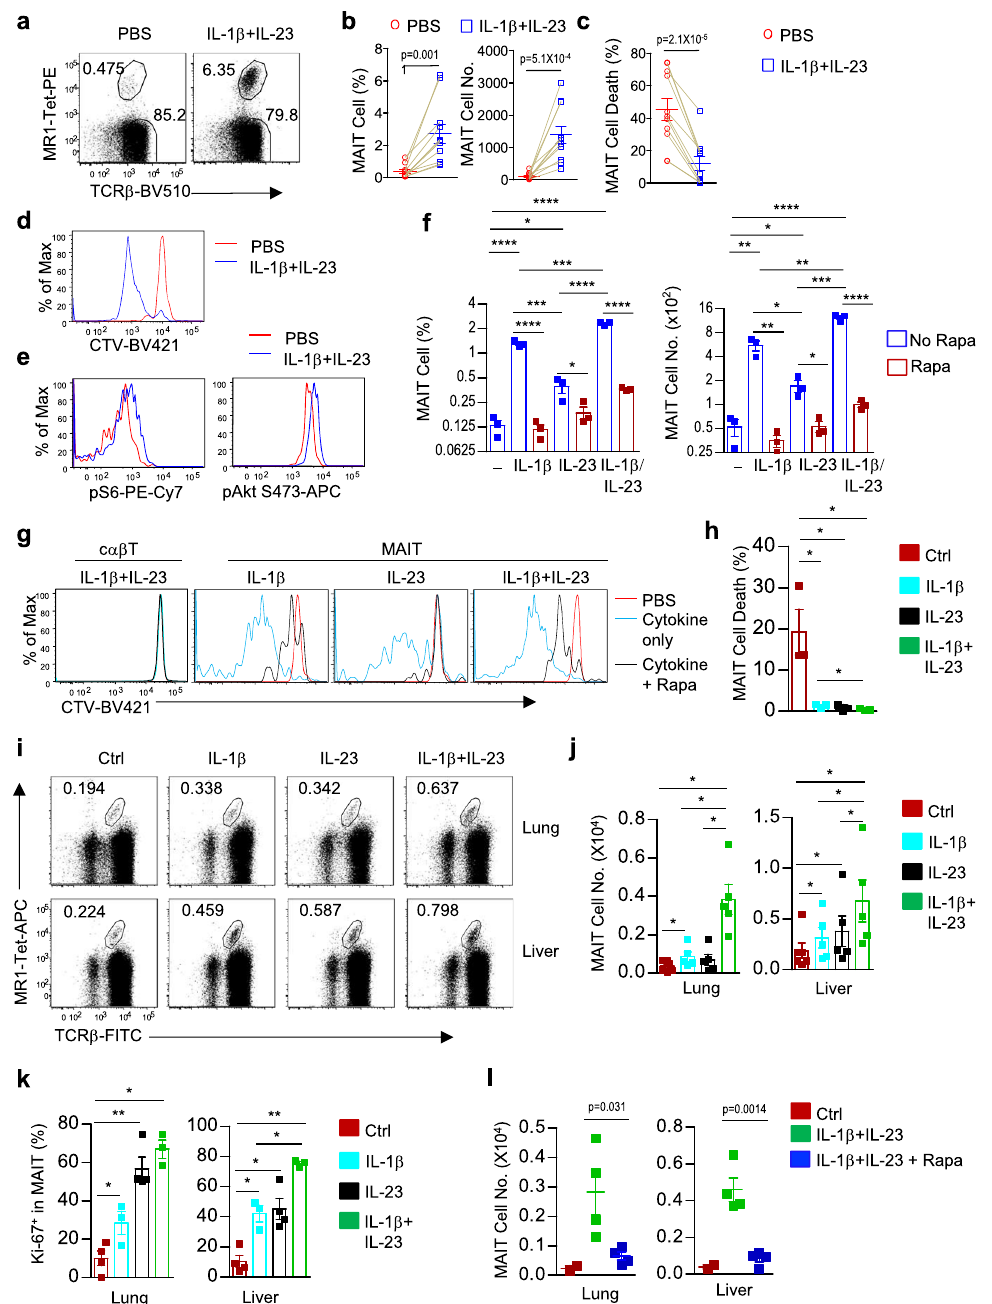
Fig. 8 IL-1 β and IL-23 induced MAIT cell expansion in vitro and in vivo. a – h Splenocytes from WT mice were treated with IL-1 β , IL-23, IL-1 β plus IL-23, or PBS directly or after labeled with CTV and examined 72 h after incubation at 37 °C. In some experiments, 20 ng/ml of rapamycin was included. a Representative FACS plots of TCR β and MR1-Tet staining of Lin − cells. b MAIT cell percentages and numbers. c Death rate of MAIT cells. d Overlaid histogram showing MAIT cell proliferation by CTV-dilution. e Representative histograms showing S6 and Akt S473 phosphorylation in MAIT cells. f MAIT cell percentages and numbers after treatment with IL-1 β , IL-23, or IL-1 β plus IL-23 in the presence or absence of rapamycin (rapa). g MAIT cell proliferation in the presence or absence of rapamycin. h Death rate of MAIT cells. i – k WT mice were i.p. injected with either IL-1 β , IL-23, IL-1 β plus IL-23, or PBS on days 1 and 2 and were examined on day 4. i Dot plots show TCR β and MR1-Tet staining in live gated Lin − CD45.2 + lung cells or liver mononuclear cells. j Bar graphs represent mean ± SEM of liver and lung total MAIT cell numbers. k Ki-67 + cells in lung and liver MAIT cells. l WT mice were i.p. injected with PBS (Ctrl), IL-1 β and IL-23, or IL-1 β , IL-23, and rapamycin on days 1 and 2 and were examined on day 4. Scatter plots represent mean ± SEM of liver and lung total MAIT cell numbers. a – e are representative of or pooled from seven to eleven experiments. Each connection line indicates one experiment. f – h are representative of two experiments and bar fi gures are mean ± SEM calculated from triplicates in one experiment. i – k are representative of or pooled from three to fi ve experiments. l is representative of two experiments. * p < 0.05; ** p < 0.01; *** p < 0.001; **** p < 0.0001 or exact p values are determined by two-tailed paired ( b , c , j , k ) and unpaired ( f , h , l ) Student ’ s t test. Source data for all graphs are provided as a Source Data fi